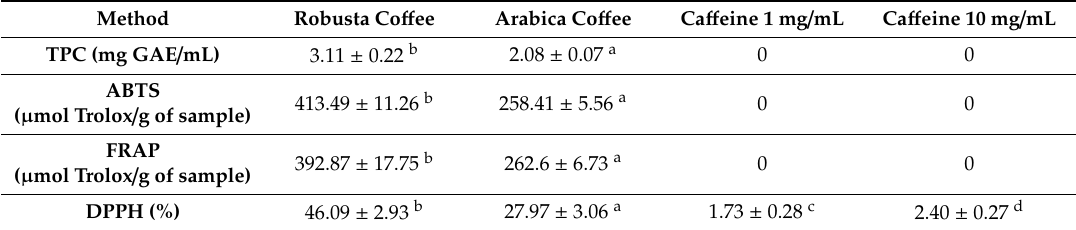
Table 2. Total phenolic content and antioxidant capacity of Arabica and Robusta co ff ee